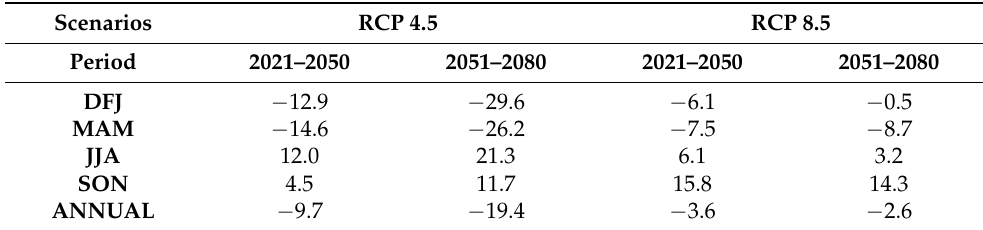
Table 2. Deviations (%) in the projected precipitation for Altamira relative to the 1981–2010